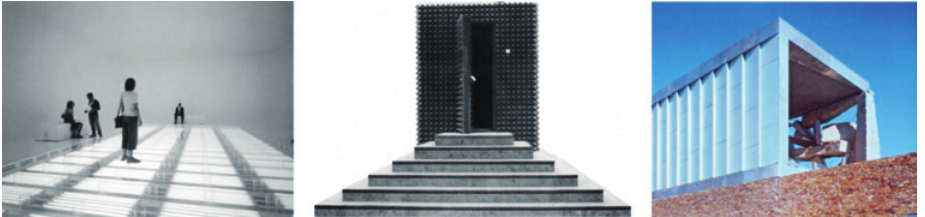
Fig. 34. Philippe Rahm, Jean­ Fig. 35. James Turrell. Soft Cell . Fig. 36. Antón Gilles Décosterd. Hormonorium .